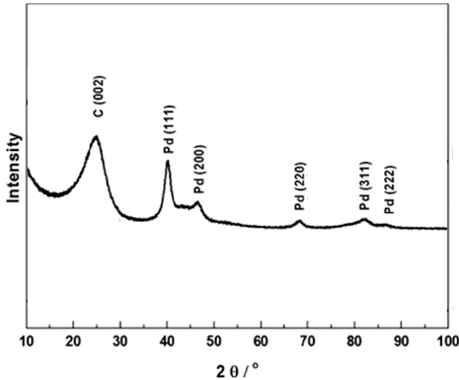
Figure 2. XRD spectra of the Pd/C catalyst employed in this work .